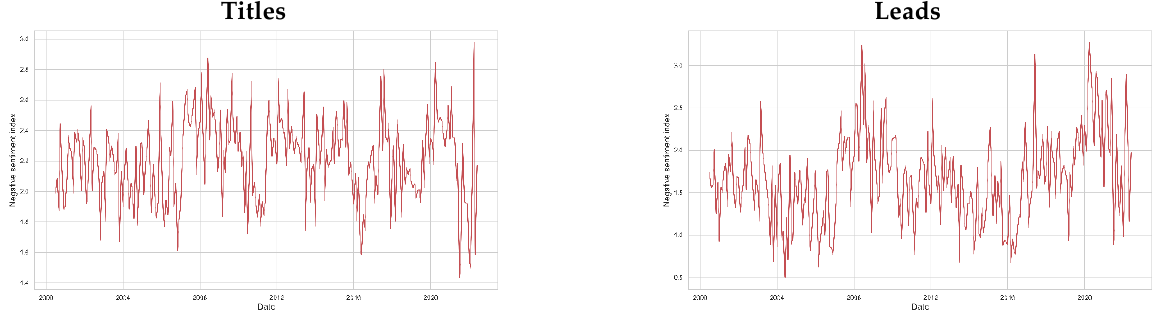
Figure A4. Sentiment analysis of news titles and leads over time for category “ Science ” news.